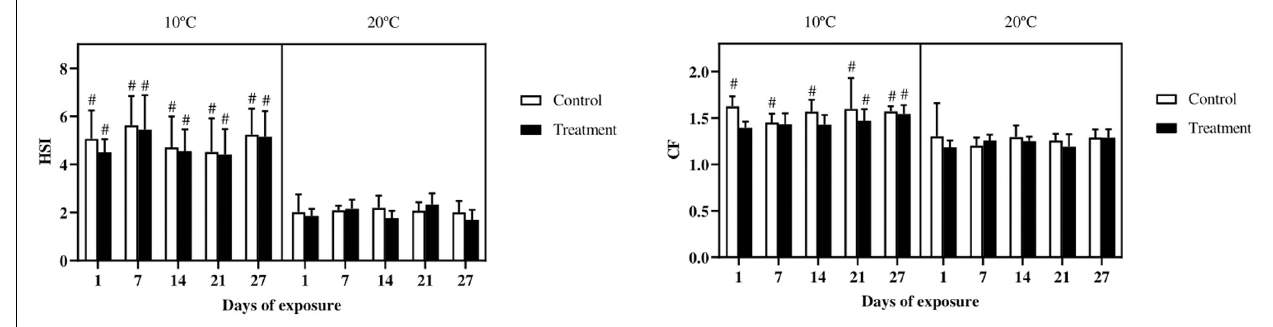
FIGURE 1 | Hepatosomatic index (HSI) and condition factor (CF), in common carp ( Cyprinus carpio ) exposed to a mixture of Cu, Zn, and Cd for 27 days both at 10 ◦ C and 20 ◦ C. Mean ± SD, N = 10. The hash (#) indicates differences between the same groups (both control and metal treated) at different temperatures ( p <